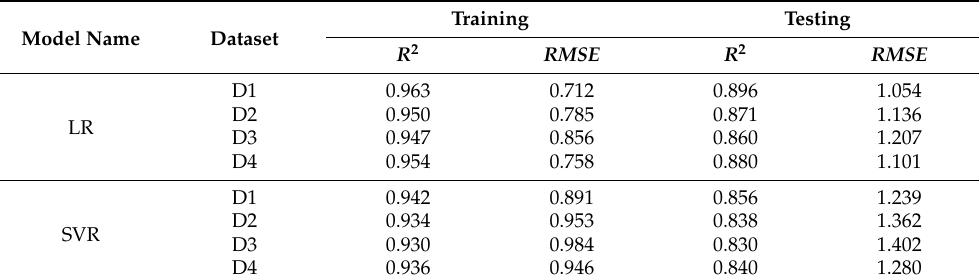
Table 3. Performance metrics ( RMSE and R 2 ) of both models for predicting the fruit weight of strawberries during the training and testing period. Italicized values indicate the best performance result for each